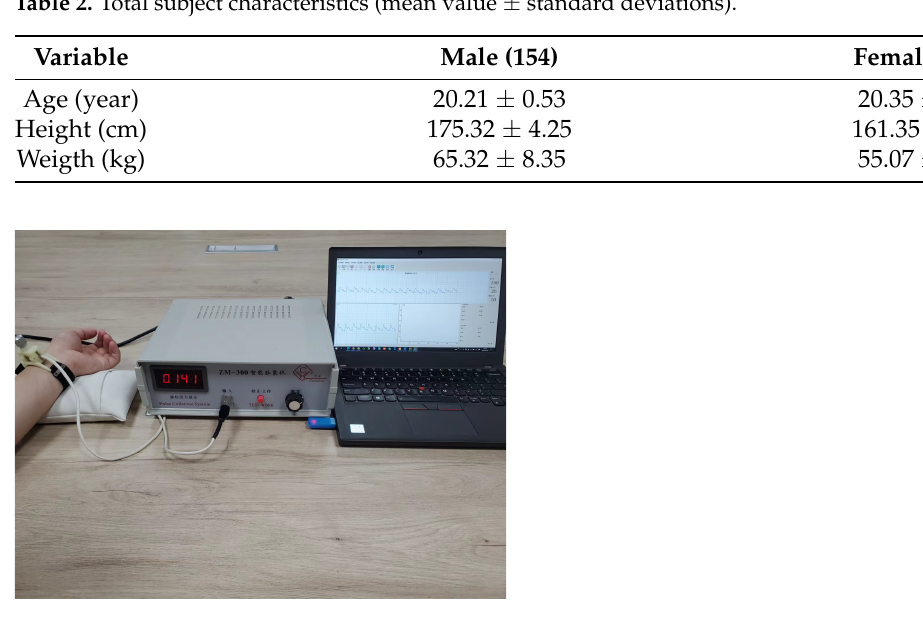
Figure 2. The pulse wave acquisition